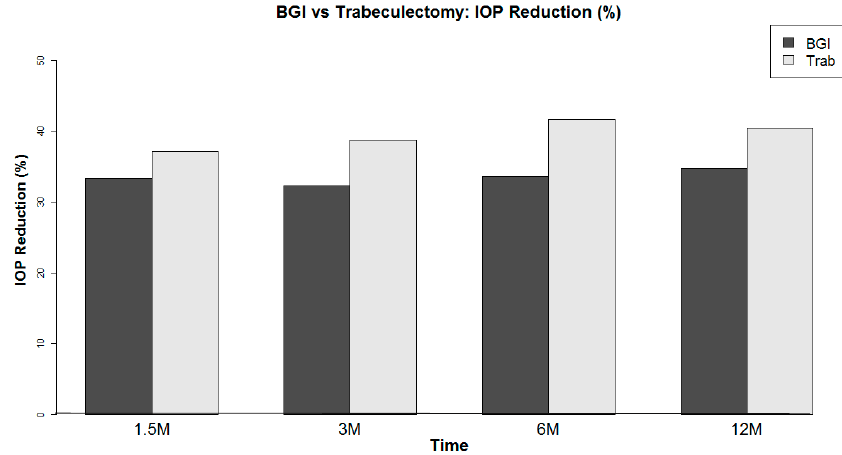
Figure 2. Percentage of IOP